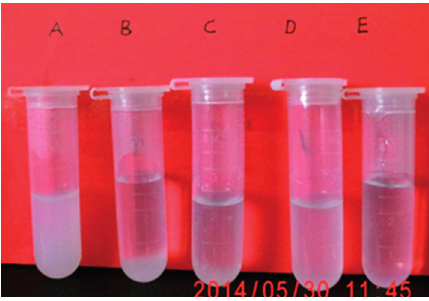
Figure 2. Photograph of dispersion of SN in water ( A ) and in Chloroform ( C ); SNA in DI water ( B ) and in Chloroform ( D ); for comparison DI water was shown as ( E